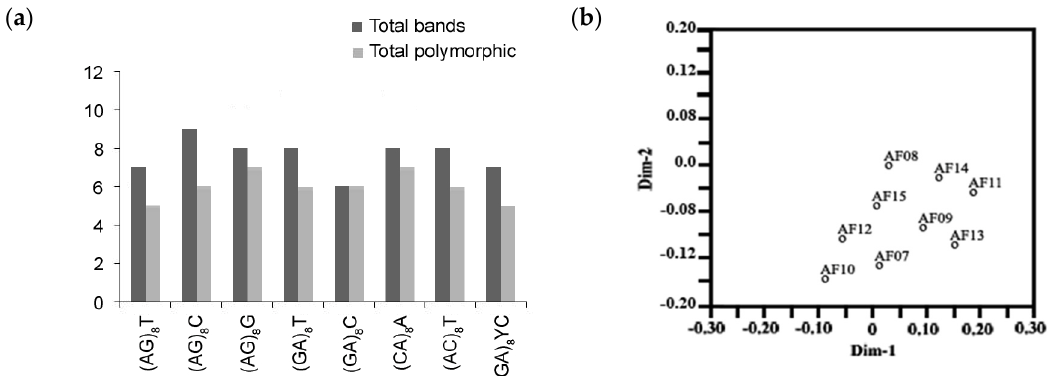
Figure 4. ( a ) Bar graph for nine A. flavus showing various fragments produced by primers and total polymorphisms produced by them, ( b ), 2D principal component analysis (PCA) based on genetic relationships from inter-simple sequence repeat (ISSR) data using the DECENTER and EIGEN features of Numerical Taxonomy and Multivariate Analysis System (NTSYSpc).